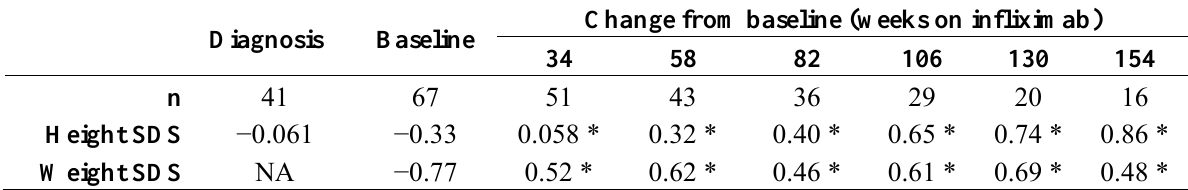
Table 3. Median height and weight-for-age standard deviation scores after commencing infliximab observations (* p < 0.05 vs.